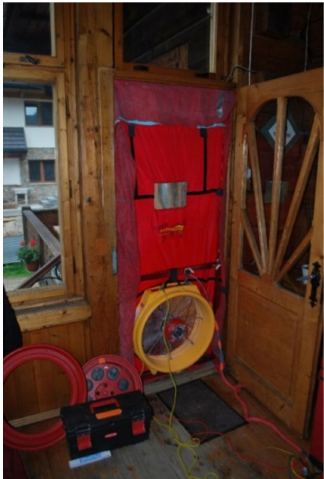
Figure 7. Envelope airtightness test performed on the Stara Polana building. Location of the Blower Door device in the entrance door. Reproduced from